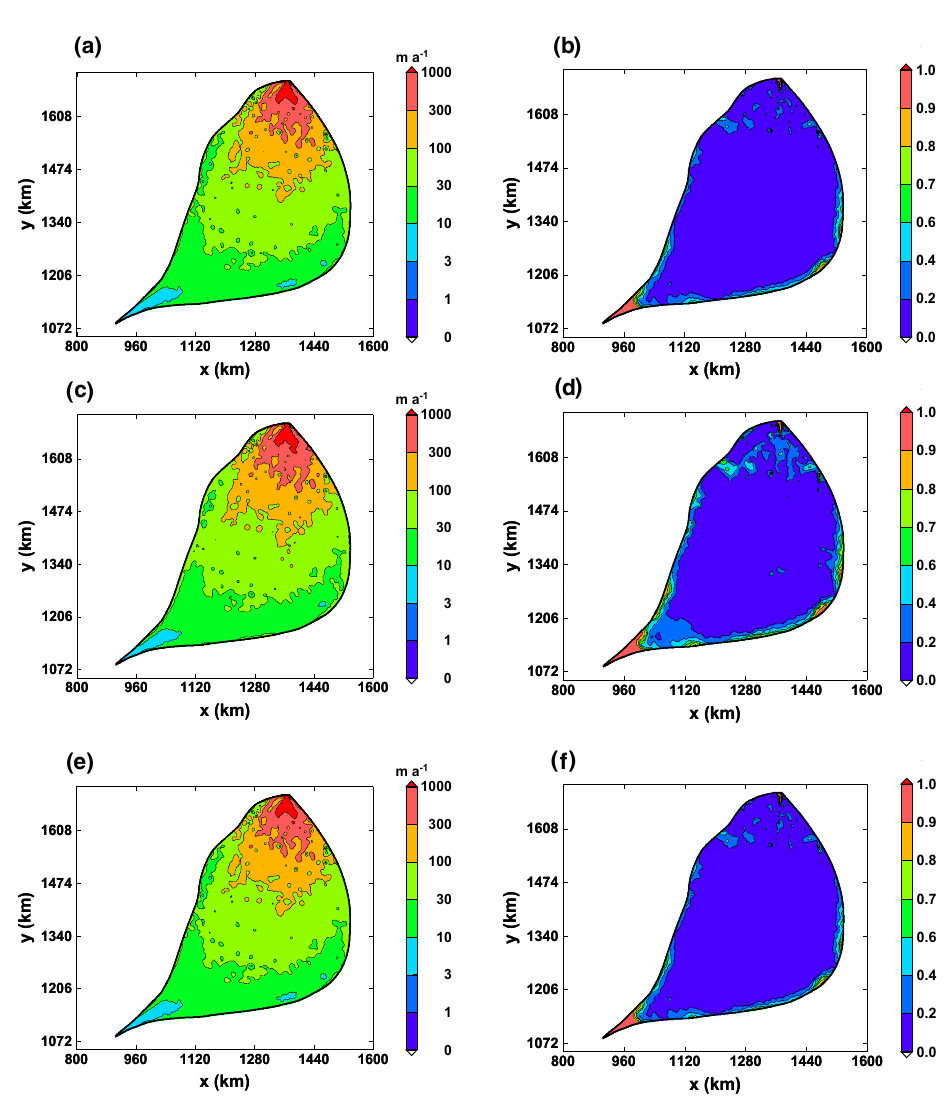
Figure 7. Surface velocities (a, c, e) and slip ratios (b, d, f) computed with the SIA dynamics for experiment CTL (constant-climate control run; a, b ), S1 (basal sliding experiment; c, d ) and C2 (surface climate experiment; e, f ) at t = 100 years (year